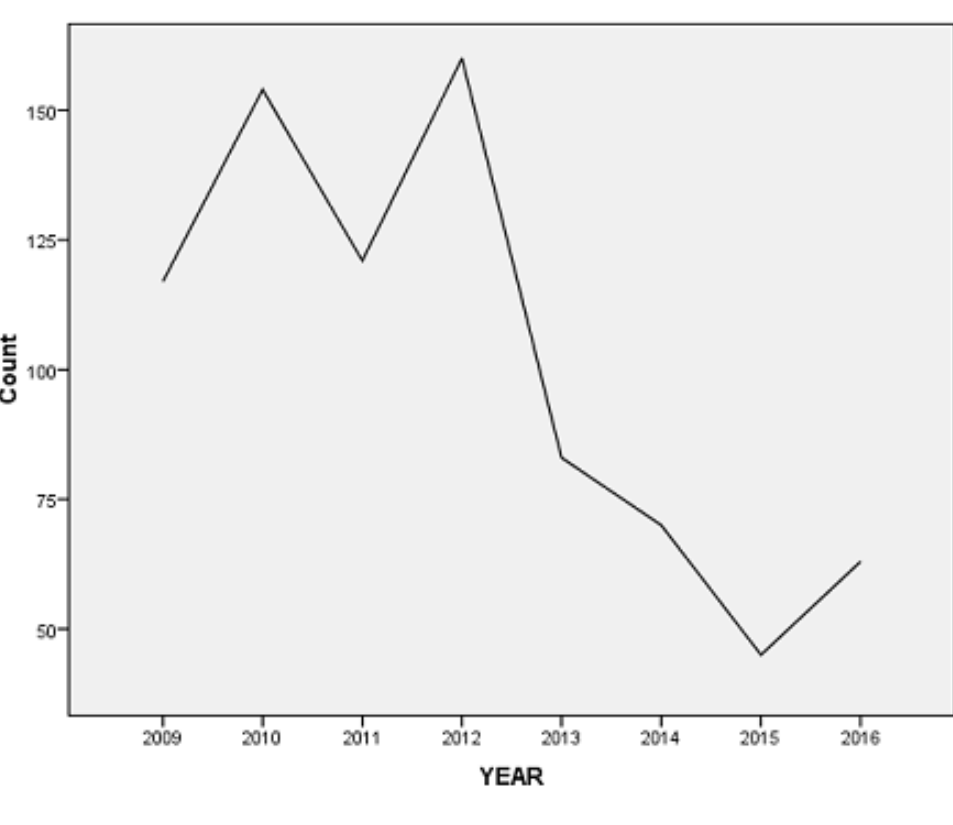
Figure 2: Annual number of admitted cases from 2009 –